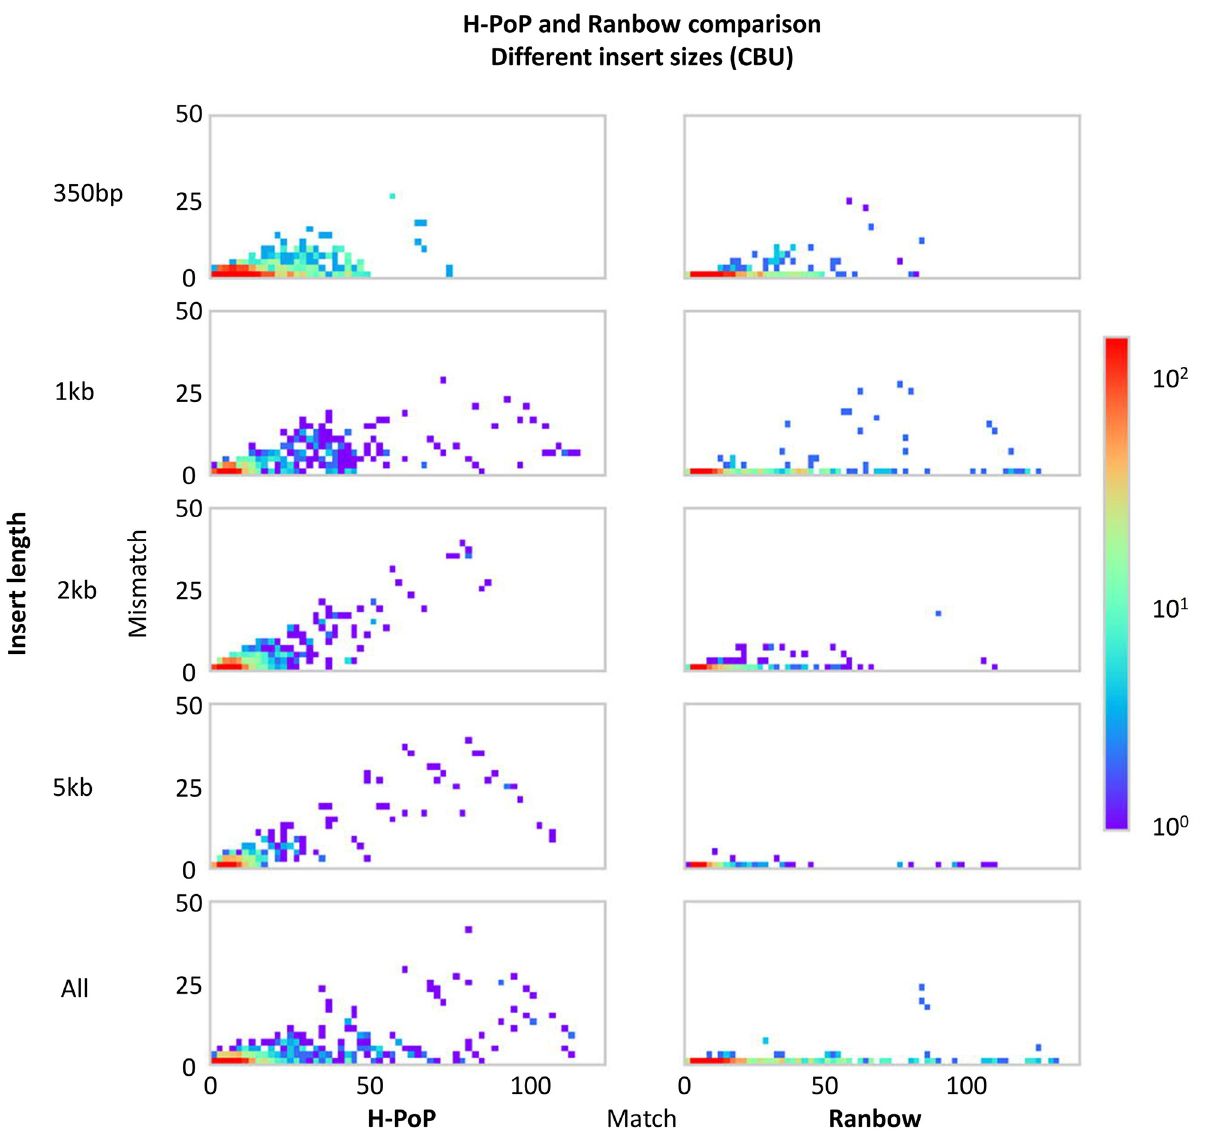
Fig 6. The comparison of H-PoP and Ranbow on different insert sizes for simulated dataset of CBU genome.